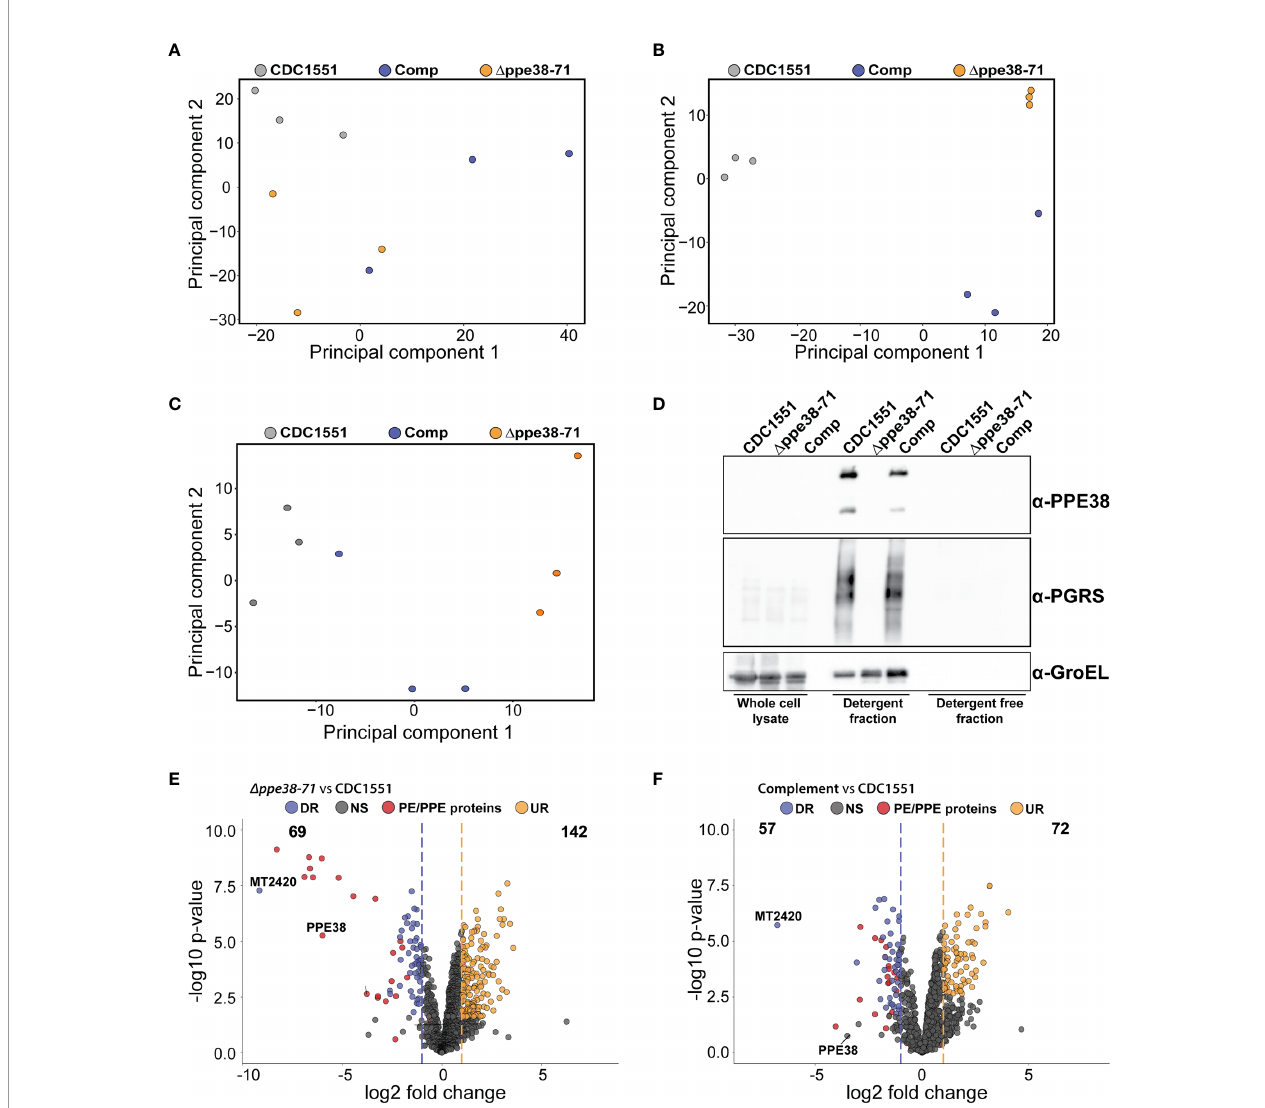
FIGURE 5 | In vitro proteomics of M. tuberculosis strains show partial complementation that can be restored by the omission of detergent. Principal component analysis of (A) whole-cell lysates, (B) supernatant containing detergent and (C) supernatant without detergent of each M. tuberculosis strain after four days of cultivation. (D) Western blot of each fraction shows the PE-PGRS proteins in the supernatant only when there is detergent present in the growth media. Volcano plots of supernatants containing detergent from (E) M. tuberculosis D ppe38-71 and (F) the complemented strain compared to M. tuberculosis CDC1551 when cultivated in detergent. The q-value was set to 0.05 and the log2 fold change was set to 1. The data is representative of three independent